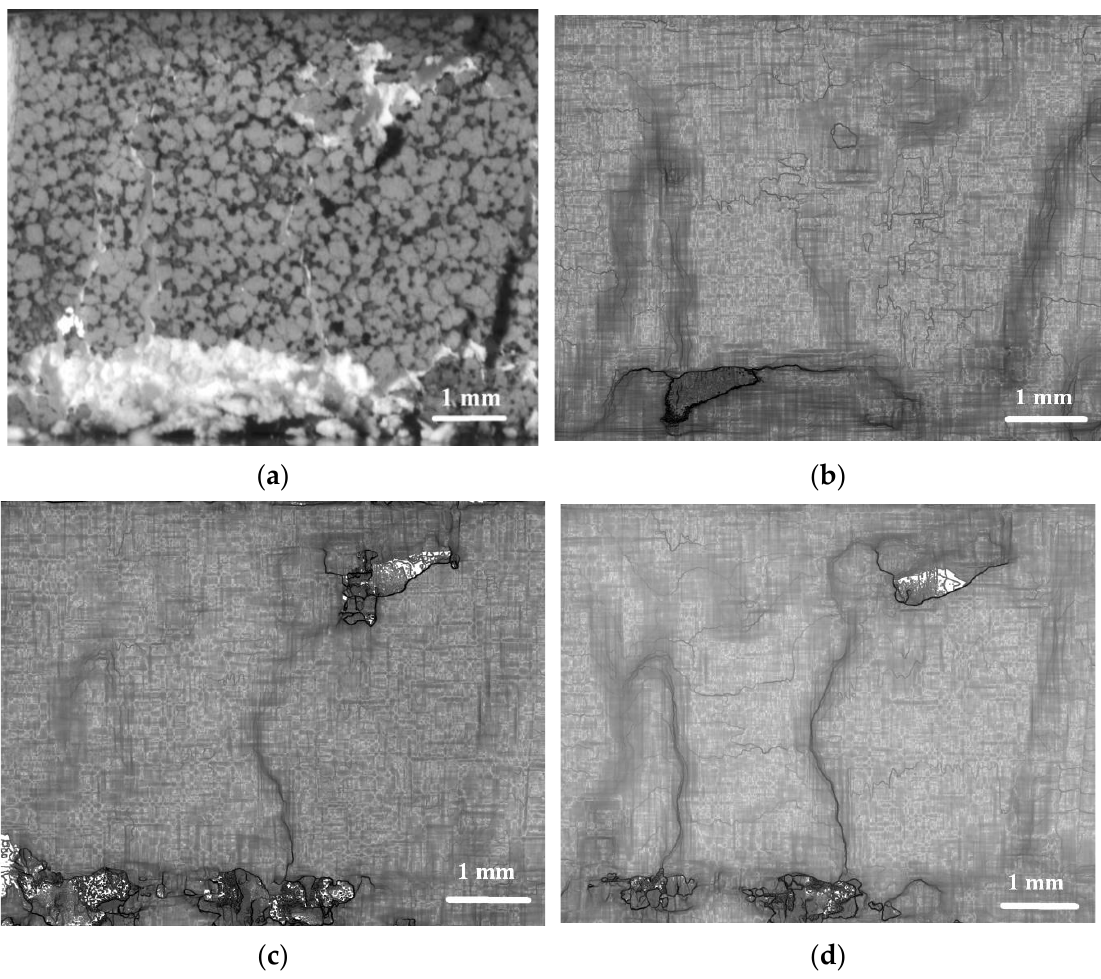
Figure 15. Optical macrograph ( a ) and deformation maps ( b – d ) of Sample #4 at the deformation Stage IV at strain are as follows: ε = 0.080 ( a ), ε = 0.076, ∆ ε = 0.0025 ( b ), ε = 0.079, ∆ ε = 0.0038 ( c ), and ε = 0.080, ∆ ε = 0.0013 ( d ).